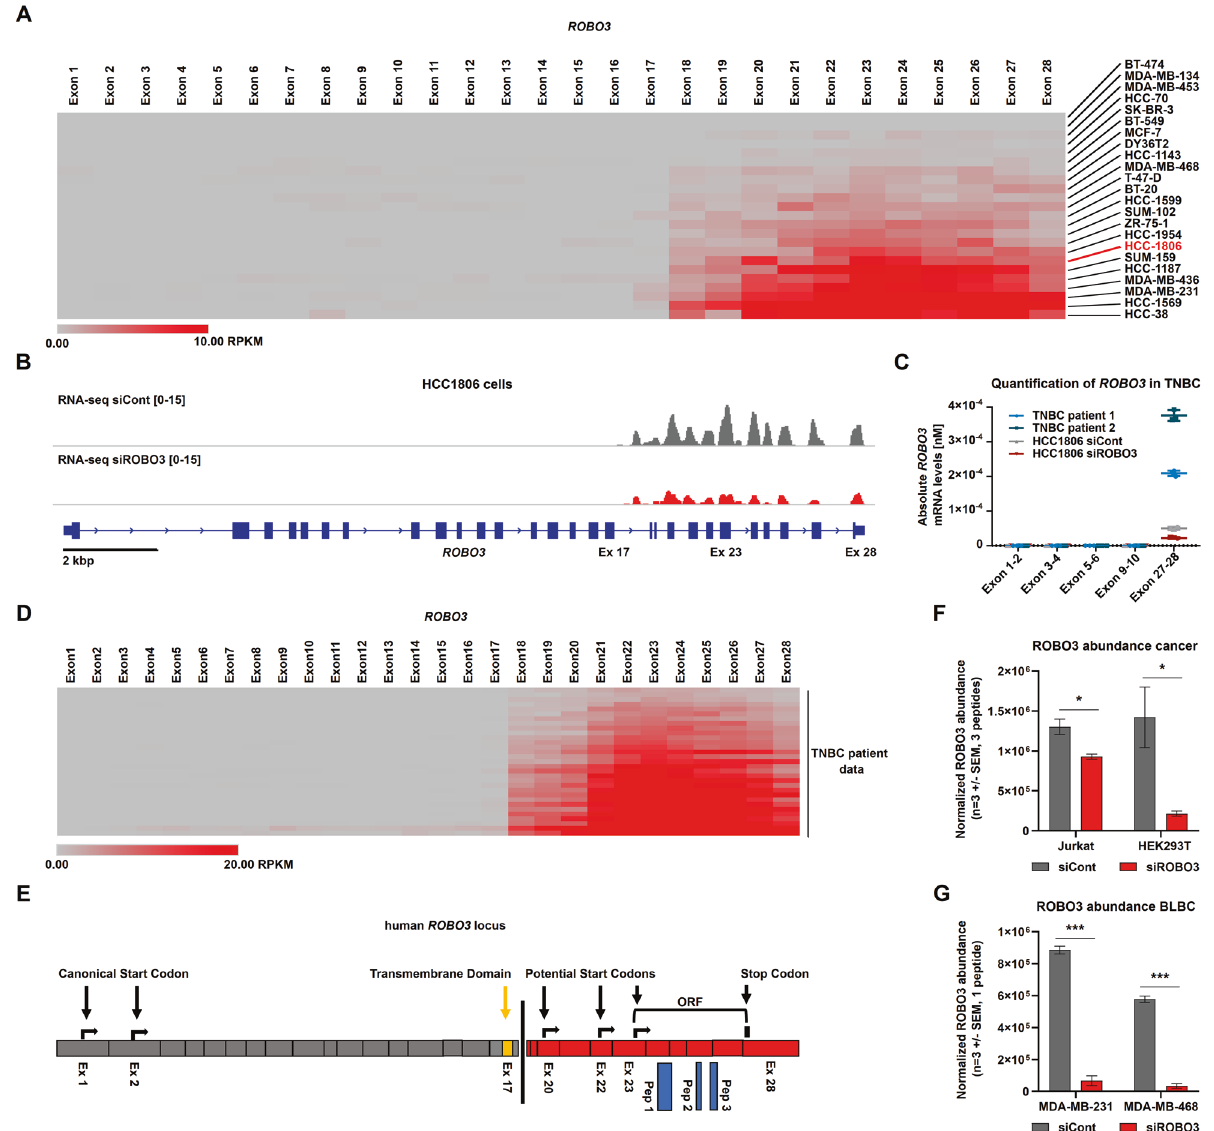
Fig. 2 Human TNBC cells express a short ROBO3 variant that supports cell proliferation and migration in vitro. A Heatmap of ROBO3 expression levels for each exon across 23 human BC cell lines derived from publicly available mRNA-seq data. Cell lines are sorted by the expression level of exon 23 based on reads per kilobase per million mapped reads (RPKM). B Reads coverage (mRNA-seq) of ROBO3 in HCC1806 cells 72 h after treatment with control or anti-ROBO3 siRNAs (siCont and siROBO3, respectively). ROBO3 signal was only detected in a region spanning from exon 17 to exon 28. siROBO3 treatment (red track) ef fi ciently reduced the ROBO3 signal compared to siCont (grey track). C qRT-PCRs with primer pairs raised against Exons 1-2, Exons 3-4, Exons 5-6, Exons 9-10, and Exons 27-28 of human ROBO3 . Absolute mRNA levels were measured in two primary TNBC cultures (passage < p5) and in HCC1806 treated with siCont or siROBO3. A signal was only obtained for the primer pair Exons 27-28. D Heatmap of ROBO3 expression levels (RPKM) for each exon across publicly available RNA-seq data sets of TBNC patients. E Schematic depiction of potentially translated (red) and non-translated (grey) ROBO3 exons. ROBO3 peptide sequences identi fi ed by mass spectrometry are mapped against the amino acid sequence (blue). ORF analysis shows three possible start codons for translation. Canonical and newly predicted ORFs of ROBO3 terminate on an identical stop codon. The coding sequence for the ROBO3 transmembrane region is absent from the novel isoform (yellow). F , G Protein abundance of human ROBO3 quanti fi ed in Jurkat and HEK293T F as well as MDA-MB-231 and MDA-MB-468 cells G after ROBO3 siRNA knockdown in comparison to a siRNA control. The area under the curve of extracted fragment ion chromatograms was summed up and averaged for three peptides unique for ROBO3. F , G: Error bars represent mean ± SEM of three biological replicates, t-test: * p < 0.05; *** p < Loss of ROBO3s impairs actin cytoskeleton structures and increases apoptosis To understand the molecular mechanisms underlying ROBO3s- mediated cancer cell aggressiveness, we performed mRNA-seq in HCC1806 cells upon ROBO3s knockdown. Differential gene expres- investigate this further, we performed Phalloidin stainings of actin sion analysis identi fi ed 246 downregulated and 158 upregulated fi bers in HCC1806 cells after ROBO3 knockdown and observed a genes in siROBO3 treated cells (Fig. 4A). Gene set enrichment